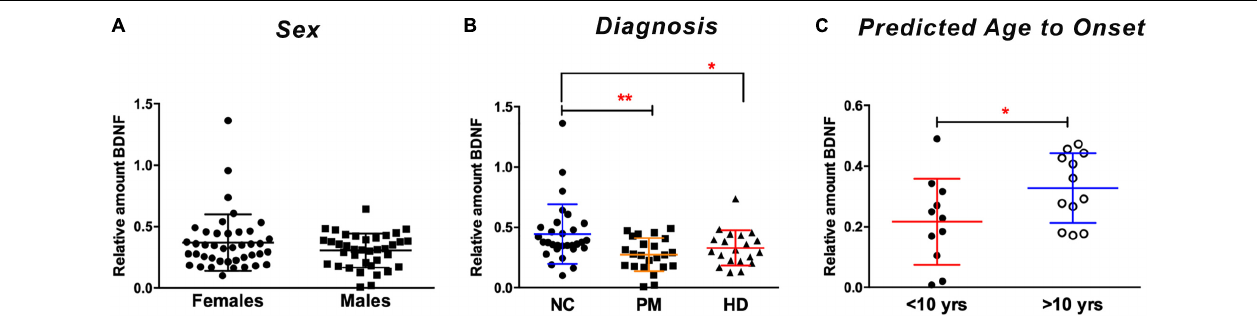
FIGURE 2 | Salivary BDNF levels according to sex and diagnostic group. BDNF levels in saliva (50 ul) were determined by ELISA. (A) No significant differences in BDNF were observed by sex (Student’s t test, unpaired; two-tailed). (B) BDNF levels are lower in premanifest (PM) and manifest HD (HD) cases when compared